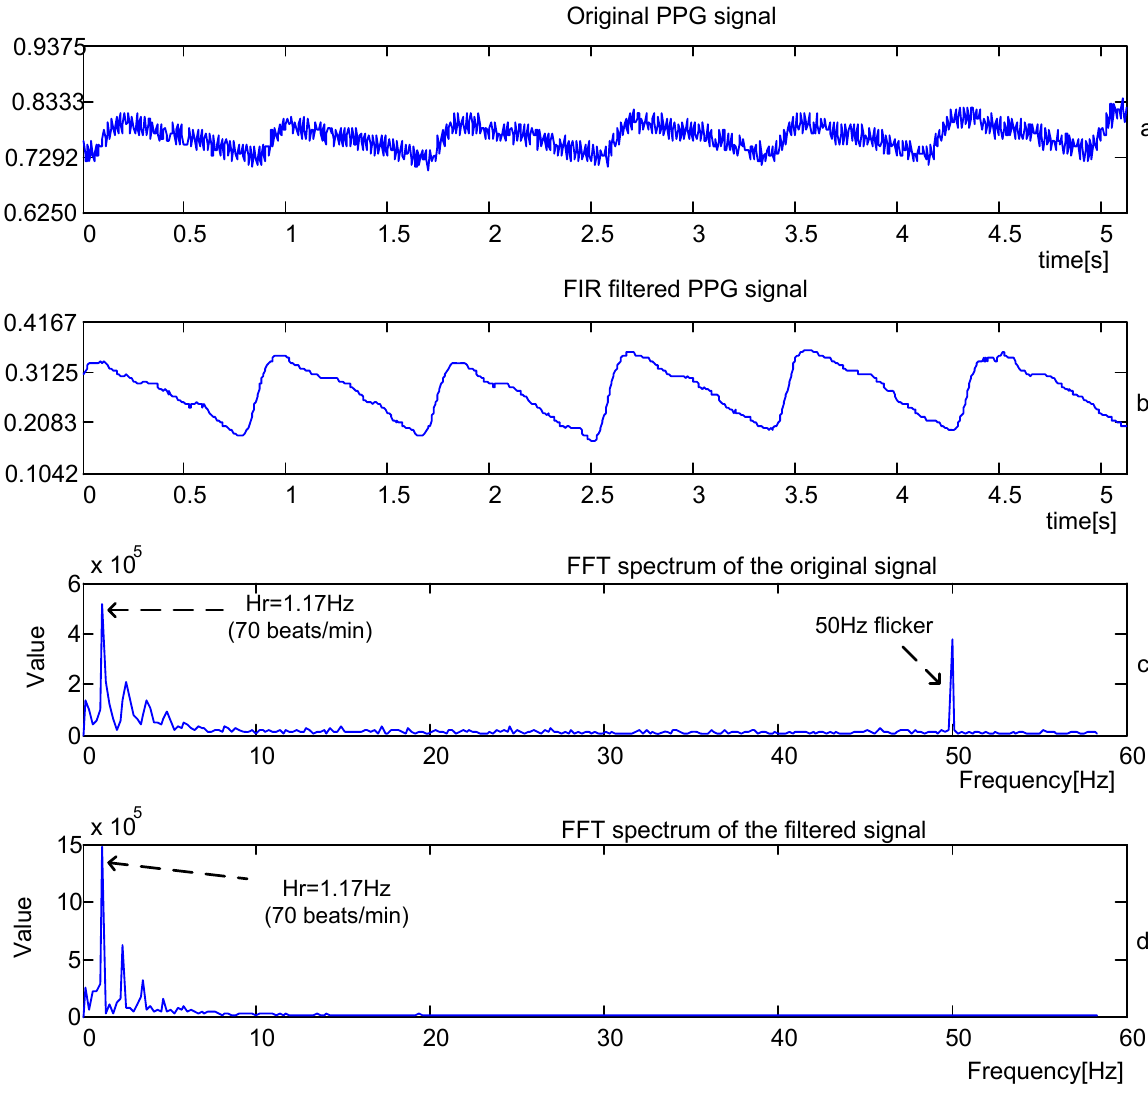
Figure 9. Experimental PPG signal ( a ) and signals obtained after processing by 16th order low pass FIR filter ( b ) and FFT, ( c ) and (d), f